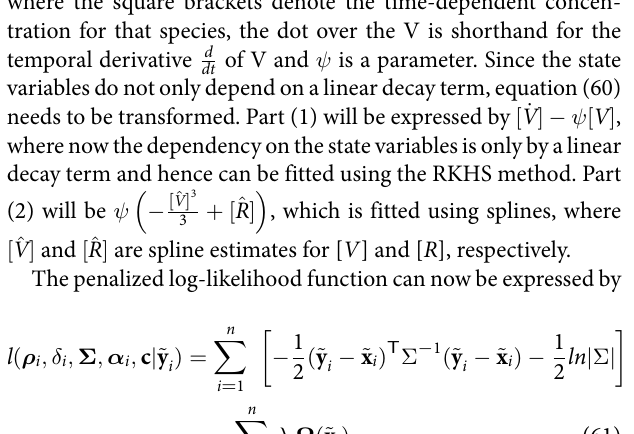
TABLE 3 | Abbreviations of the methods used throughout this review